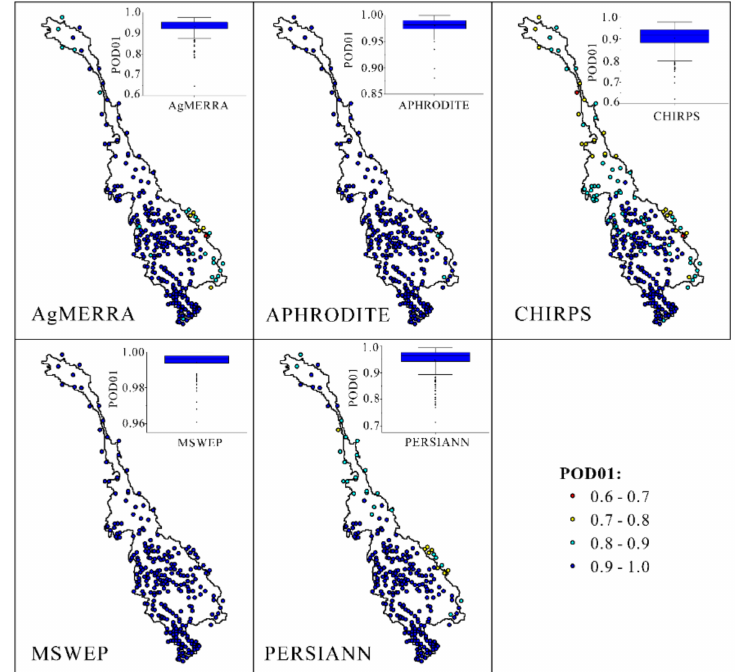
Figure 6. Same as Figure 5 but for POD01.